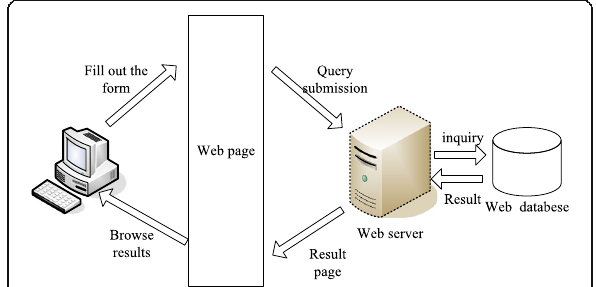
Fig. 1 Overall structure model of web data mining in big data